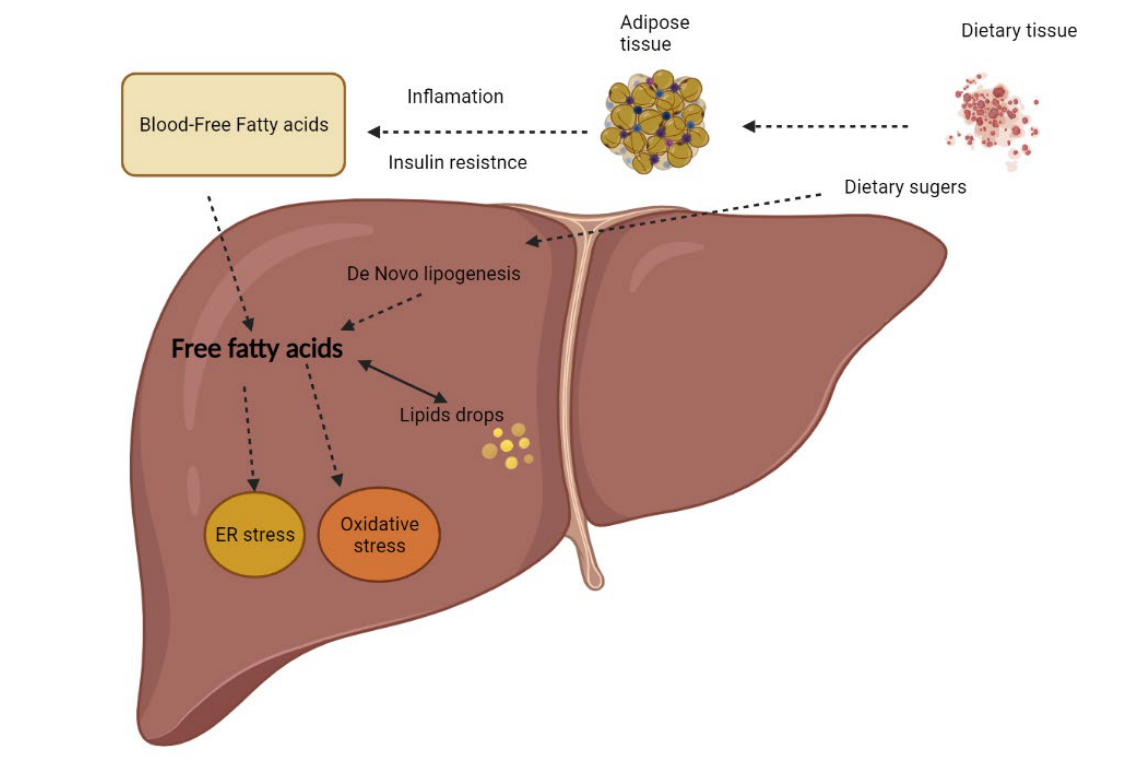
Figure 1. the pathogenesis of NAFLD, modifie d fro m